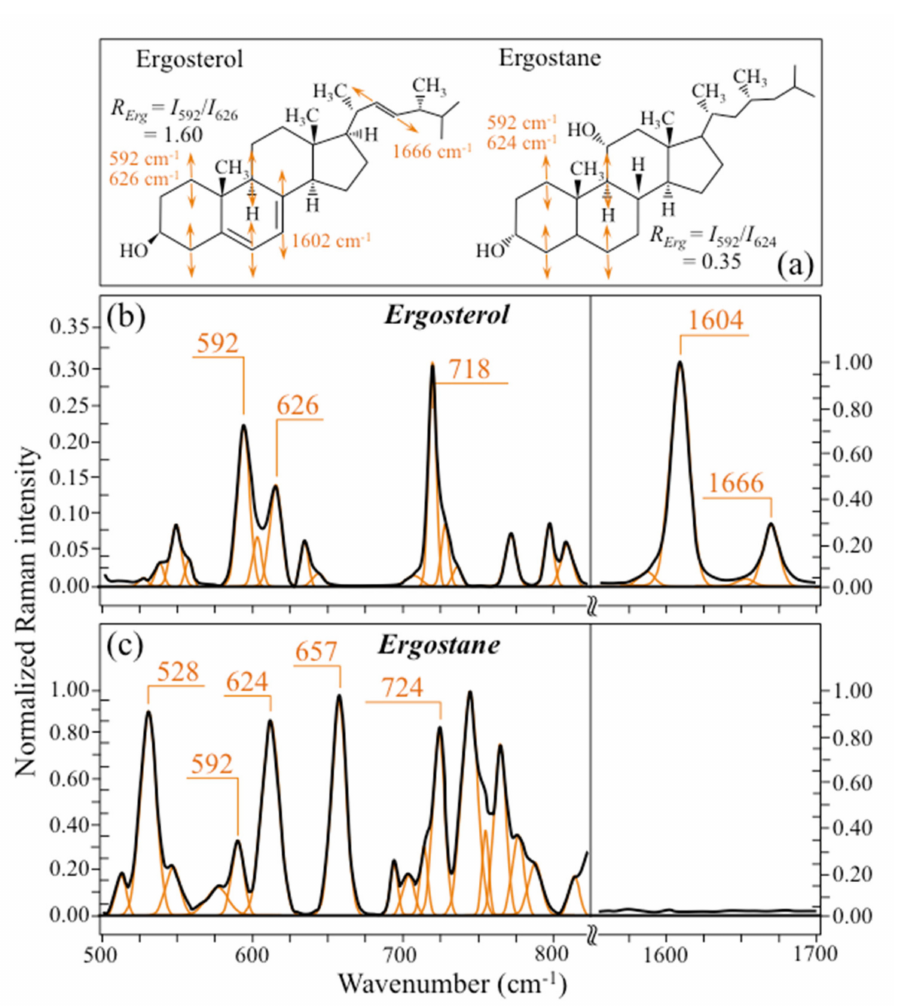
Figure 7. ( a ) Structures of ergosterol and ergostane molecules with their characteristic vibrational fingerprints and their respective Raman spectra (in ( b ) and ( c ),